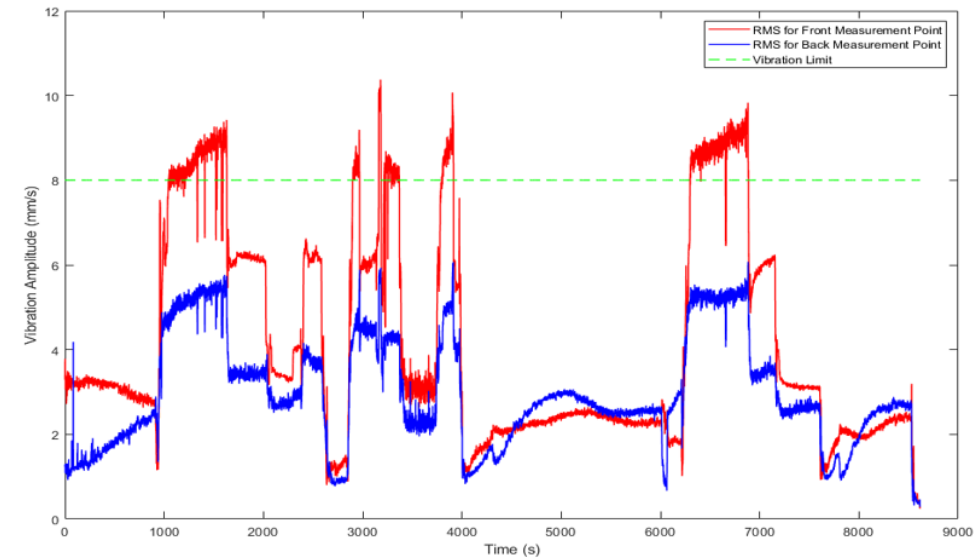
Figure 7. RMS for gas turbine vibration signals.